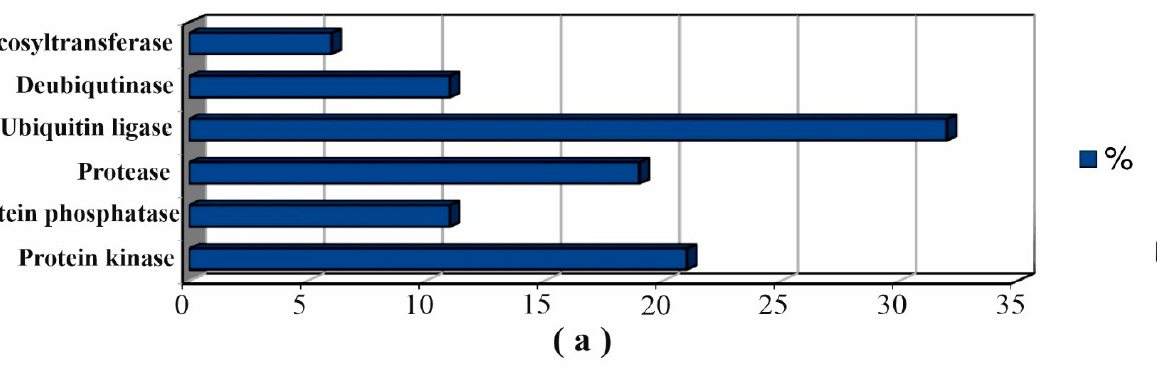
Figure 5. Annotation of modifying protein partners of target enzymes: distribution of functional classes ( a ); involvement in cancer pathways ( b ); enrichment with cancer hallmarks terms ( c ). Figure 5A shows that ubiquitin ‐ protein ligases and protein kinases were the main functional classes of modifying protein partners which was in agreement with the known PTMs sites on the cholesterol synthesis enzymes (Figure S8, Supplementary File #1). The diagrams in Figures 5B and 5C and the data in Table S3 demonstrated that protein kinases (AMPK, PRKACA, MEK5/ERK5, GSK3B, PKC and ILK), protein phosphatases (PP2A, PPP1CB, DUSP6 and PTPN5) and proteases (CTSL, CASP7 and CAPN1) are highly en ‐ riched in terms of cancer hallmark and cancer pathways terms. 4. Discussion 4.1. Mapping of Protein–Protein Interaction PPIs represent four major types: (1)—two proteins form a direct complex through physical contacts; (2)—proteins interact with the same protein, without forming a direct complex with each other (indirect complex formation); (3)—both proteins are combined in a single metabolic cascade, but do not form either a direct or indirect complex; (4)—a functionally significant multi ‐ protein complex, with each component interacting physi ‐ cally with one or more adjacent components [120,121]. Studies of sub ‐ interactome of an